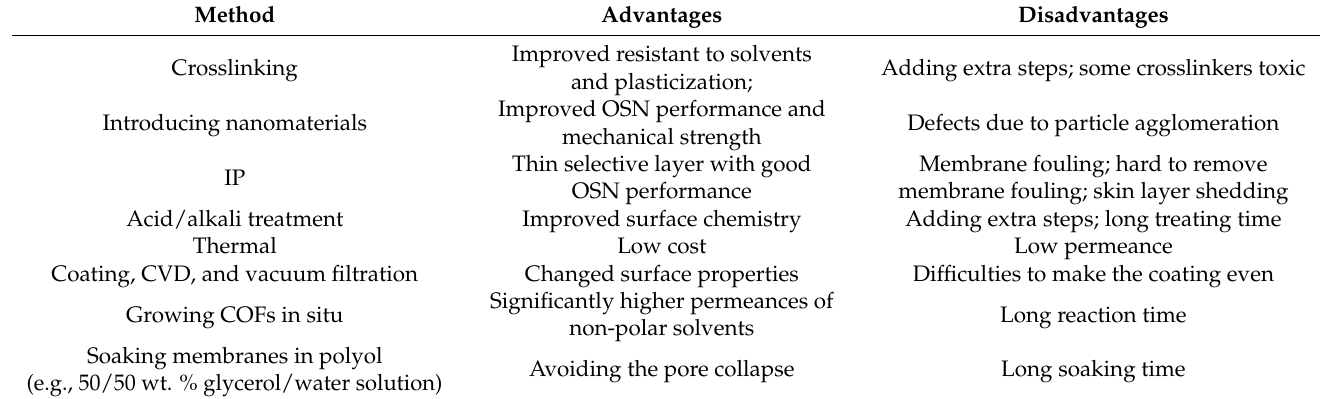
Table 4. Treatment methods of HF OSN